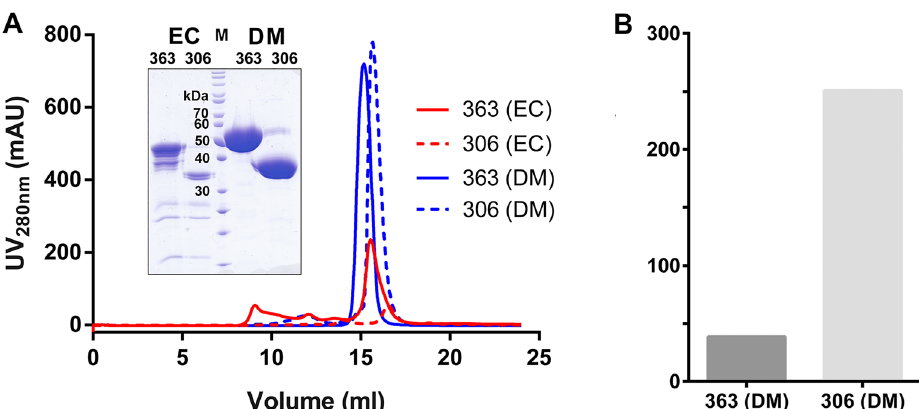
Figure 3. Comparison of recombinant expression yields in E. coli and insect cells. Expression in S2 cells results in higher yields, purity and shows no correlation with construct length. ( A ) Size exclusion chromatograms and SDS-gel (inset) of shortest (dashed line) and longest (full line) ISG65 constructs expressed in E. coli and insect cells. Bacterial culture volumes were tenfold higher. The protein gel was digitally cropped for clarity. The complete gel is shown in Supplementary Figure 3. ( B ) Expression yields normalised to 1 L of cell culture. Normalised yields were 38-fold (longest construct, dark grey), and, respectively, 250-fold higher (shortest construct, light grey) for the same constructs expressed in insect cells. EC, E. coli ; DM Drosophila melanogaster; M,